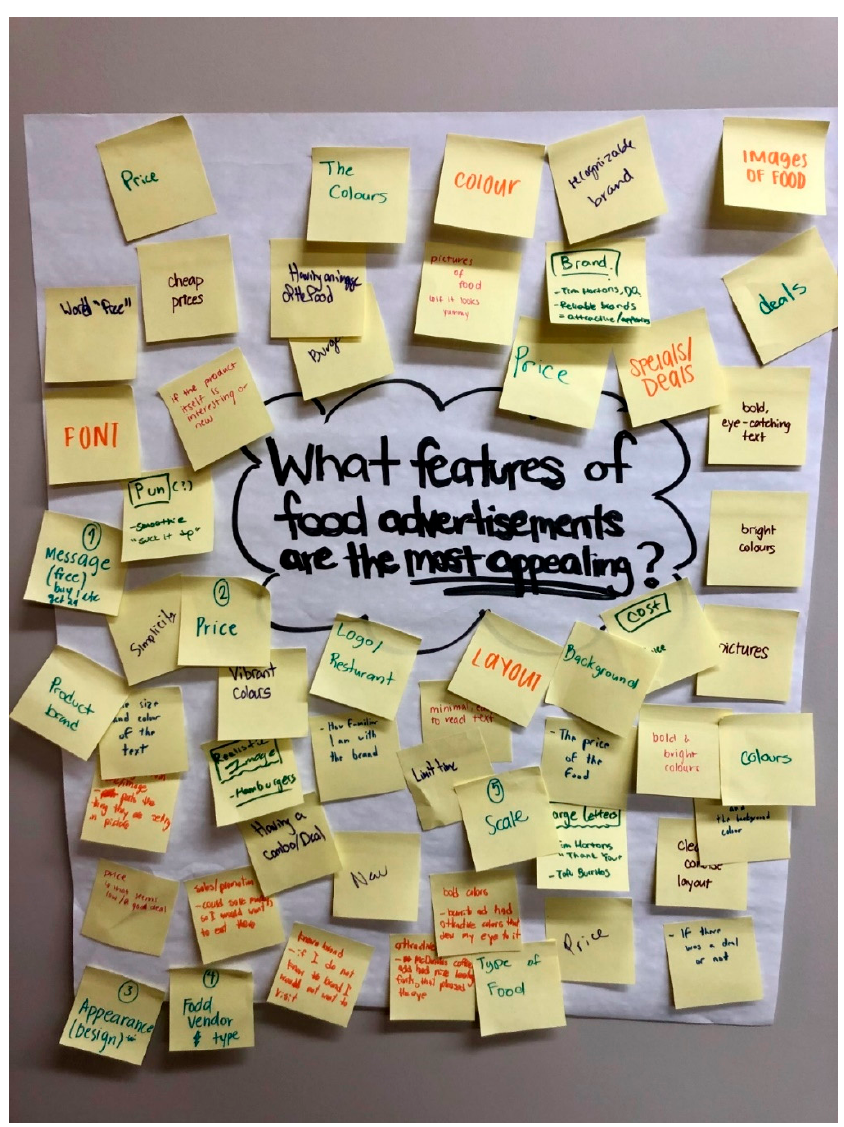
Figure 2. Youth advisory council members depict the top advertisement features that attract them and draw them inside food vendors.